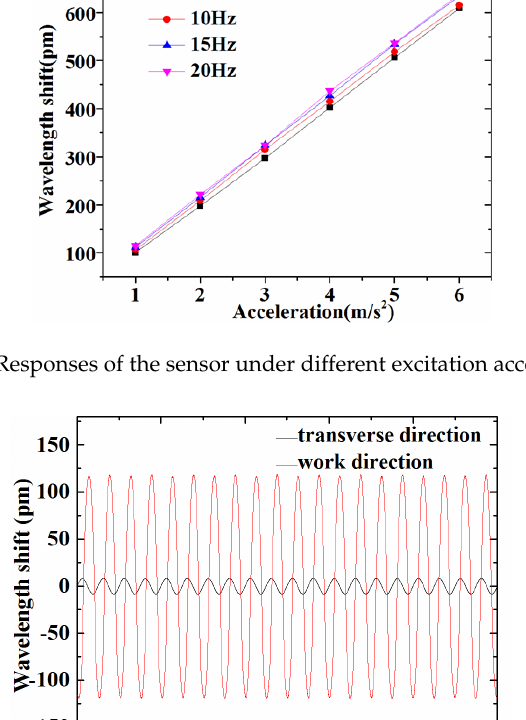
Figure 7. Responses of the sensor under different excitation accelerations.